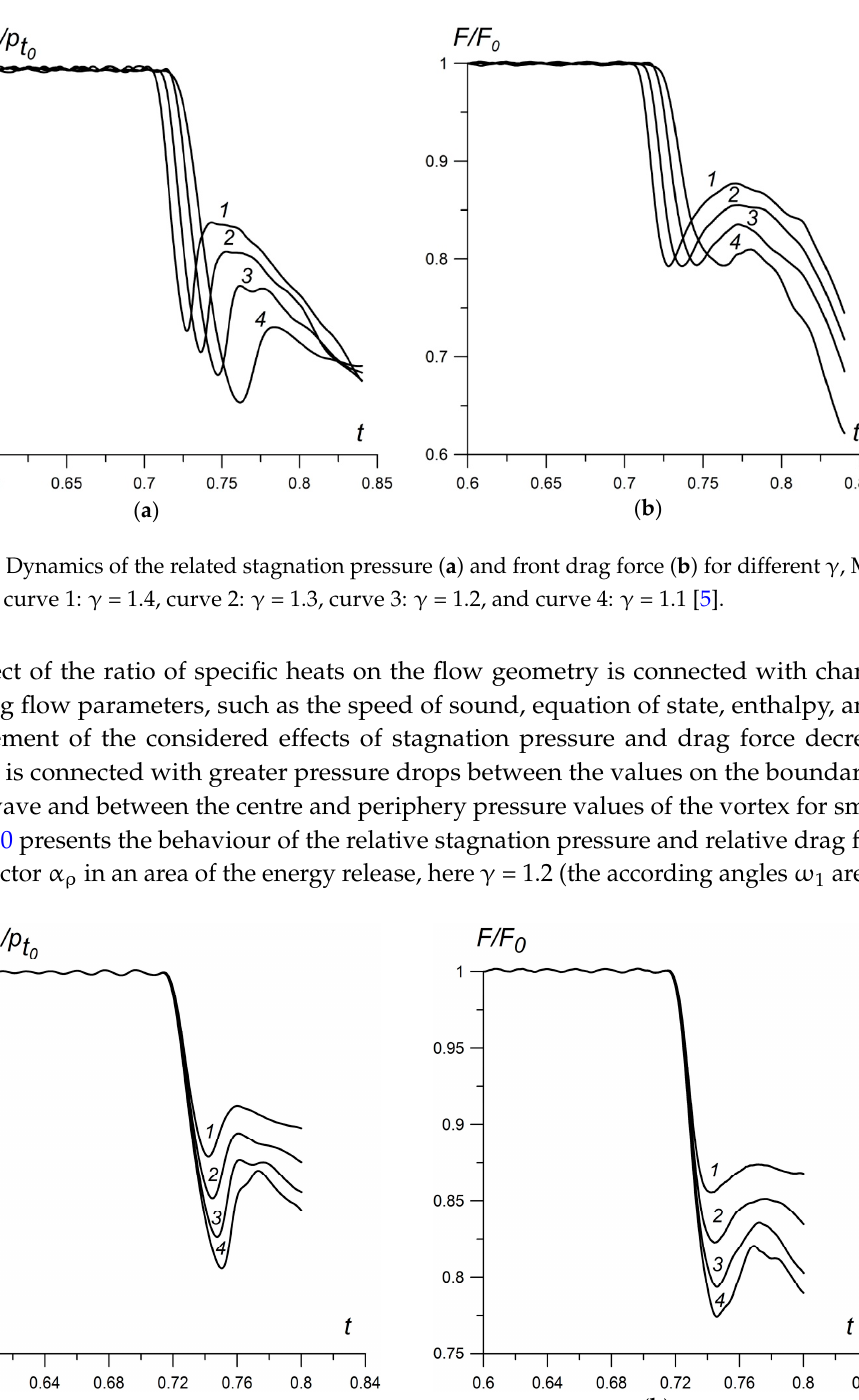
Figure 10. Dynamics of the related stagnation pressure ( a ) and front drag force ( b ) for different α ρ , M = 4, γ = 1.2: curve 1: α ρ = 0.67 ( ω 1 = 55°), curve 2: α ρ = 0.59 ( ω 1 = 50°), curve 3: α ρ = 0.5 ( ω 1 = 45 °), curve 4: α ρ = 0.41 ( ω 1 = 40°).